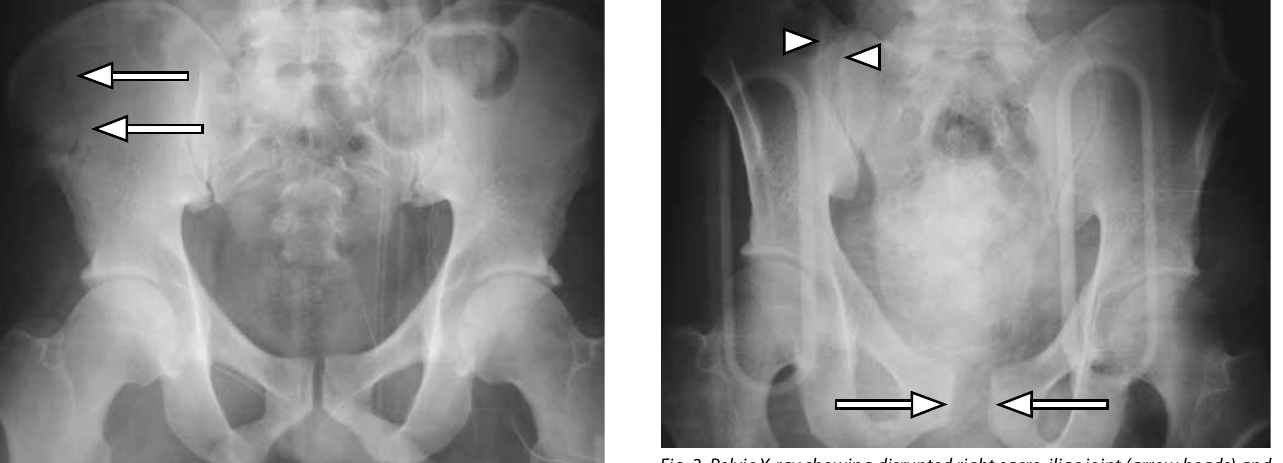
Fig. 2. Pelvic X-ray showing disrupted right sacro-iliac joint (arrow heads) and diastasis (arrows) of the pubic symphysis in patient